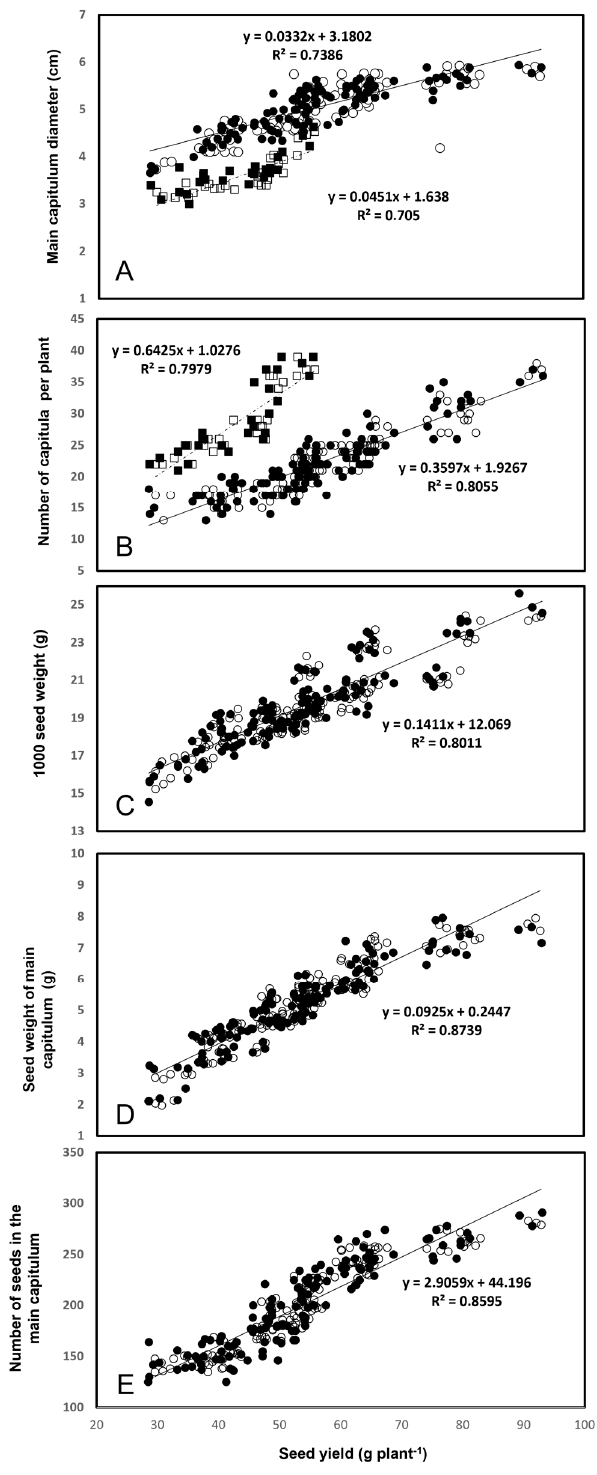
Figure 5. Main capitulum diameter ( A ), number of capitula per plant ( B ), 1000–seed weight ( C ), seed weight of the main capitulum ( D ), and number of seeds in the main capitulum ( E ) as a function of seed yield per plant in five milk thistle ecotypes (‘Ahvaz’, ‘Budakalazi’, ‘Khomin’, ‘Khoram Abad’, and ‘Sari’), cultivated under application of chitosan or TiO 2 treatments (bulk, nanoparticles) at three concentrations (0, 50, and 100 mg L − 1 ). Data of all ecotypes and treatments were pooled across years (Year 1, open symbols; Year 2, closed symbols). In panels A and B, the dashed lines represent ecotype ‘Khoram Abad’ (denoted by squares), which was analyzed separately from the remaining four